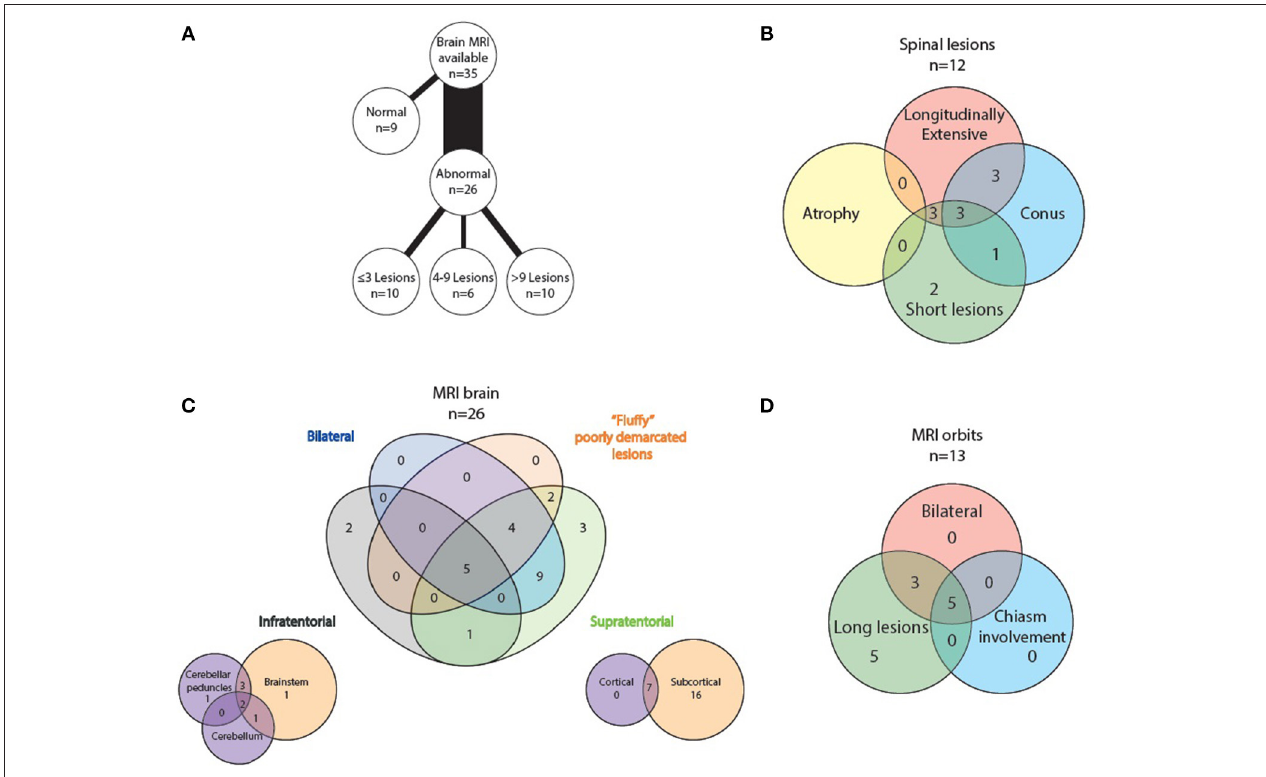
FIGURE 8 | Radiological features of MOG positive MRI scans: (A) lesion load on abnormal brain scans, (B) spinal lesion characteristics, (C) MRI brain topography, and (D) optic nerve lesion